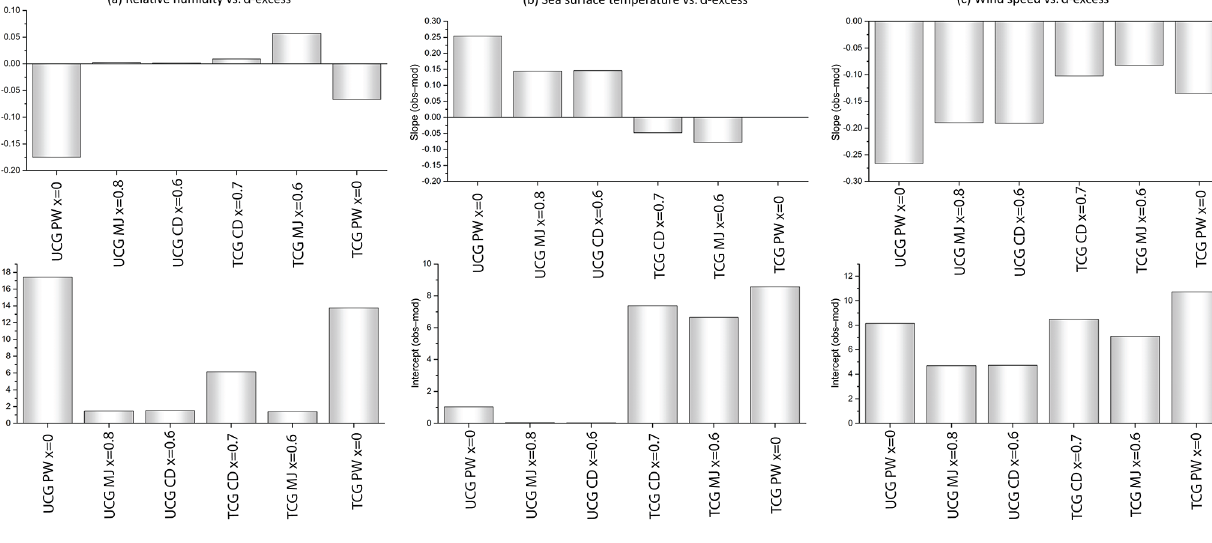
Figure 10. Differences between observed and predicted slopes and intercepts of the relationships between d-excess vs. relative humidity, sea surface temperature and wind speed. Table 3. Slope, intercept and r 2 of the linear regression equations between observed and modeled δ 18 O and d-excess for the best-fit models for samples collected north of 65 ◦ S. Observed vs. modeled Intercept